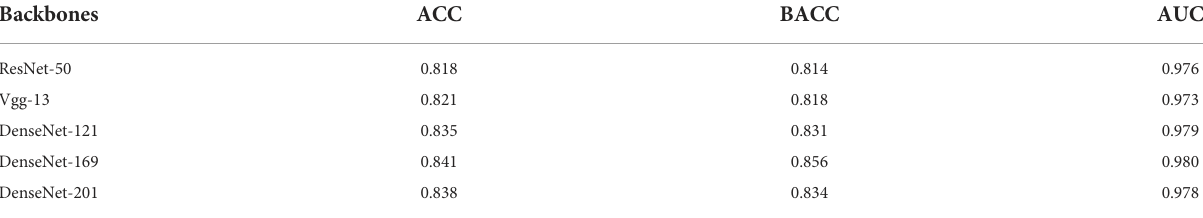
TABLE 5 Comparing the performance of different CNNs models incorporating MD-Net modules on the ISIC 2019 dataset.